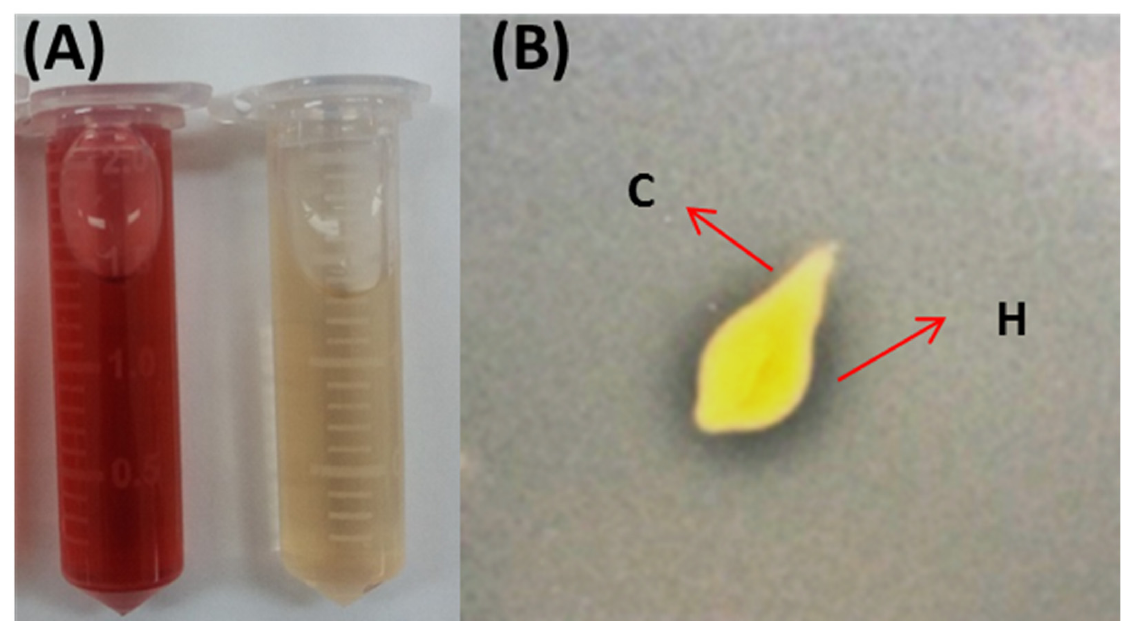
Figure 3. Qualitative tests to evaluate the production of exogenous IAA ( A ) and phosphorus solubilization ( B ) by a strain of C. vulgaris isolated from soil. In ( A ), the tube on the left shows the reaction with the microalga compared to the tube on the right (negative control). In ( B ), ‘C’ indicates the colony, and ‘H’ indicates the solubilization halo in the medium with insoluble phosphate.